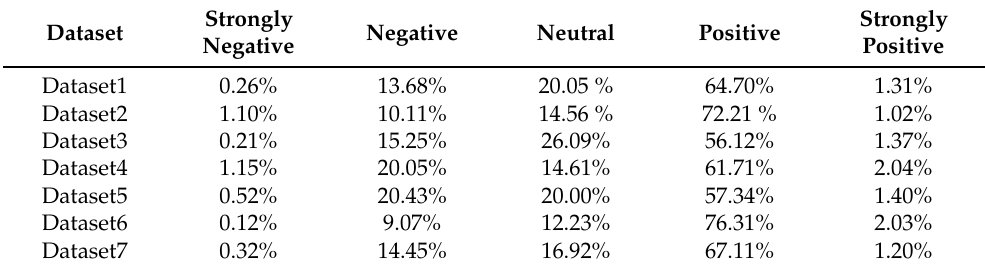
Table 4. Percentage of sentiment analysis results based on SenticNet7.